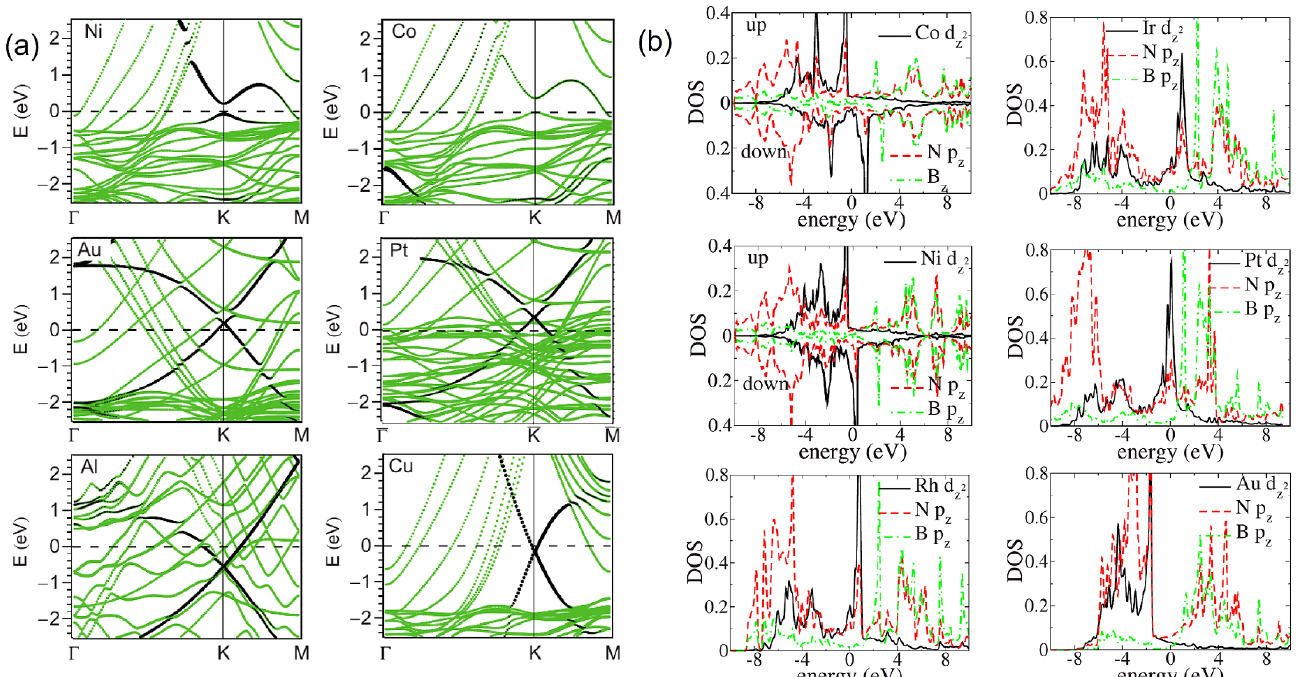
Figure 6. ( a ) Band structures of Gr adsorbed upon the (111) surfaces of Ni, Co, Au, Pt, Al, and Cu. Adapted with permission from Reference [99]. Copyright 2009, American Physical Society. ( b ) Electronic densities of state (DOS) of h-BN adsorbed upon Co, Ni, Rh, Ir, Pt, and Au. Adapted with permission from Reference [115]. Copyright 2008, American Physical